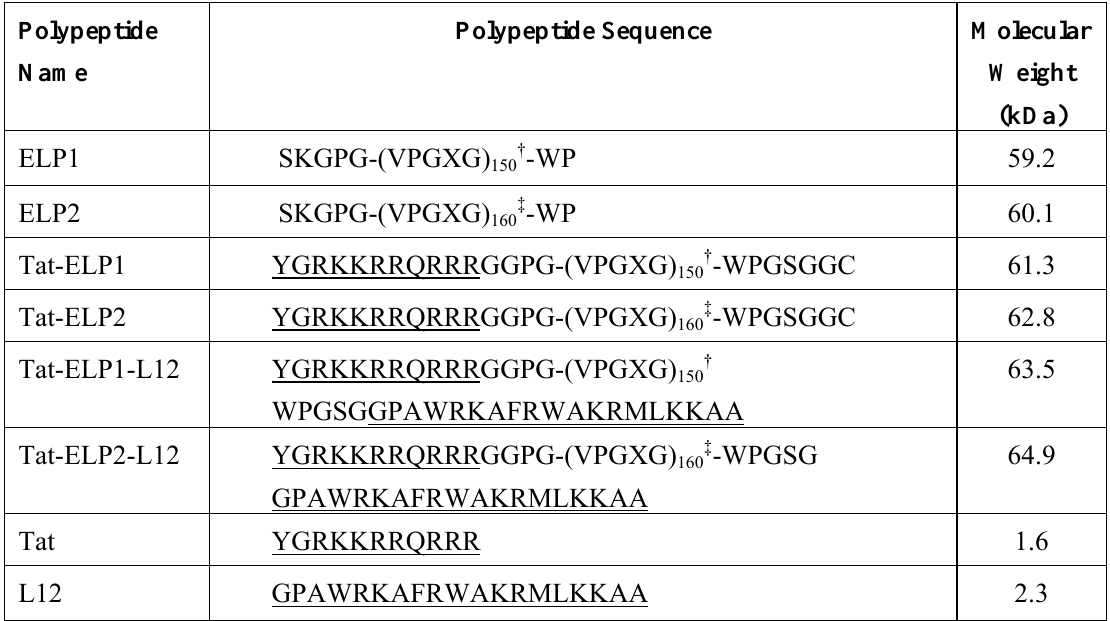
Table 1. Polypeptides used in cell proliferation experiments. ELP is a genetically engineered construct, whose sequence can be modified to include the Tat peptide at the N - terminus and the lytic peptide, L12, at the C -terminus. Both, Tat and L12, are underlined; the intervening sequences are spacer sequences. The following peptides were used to parse the cytotoxic effect of the individual components in the drug